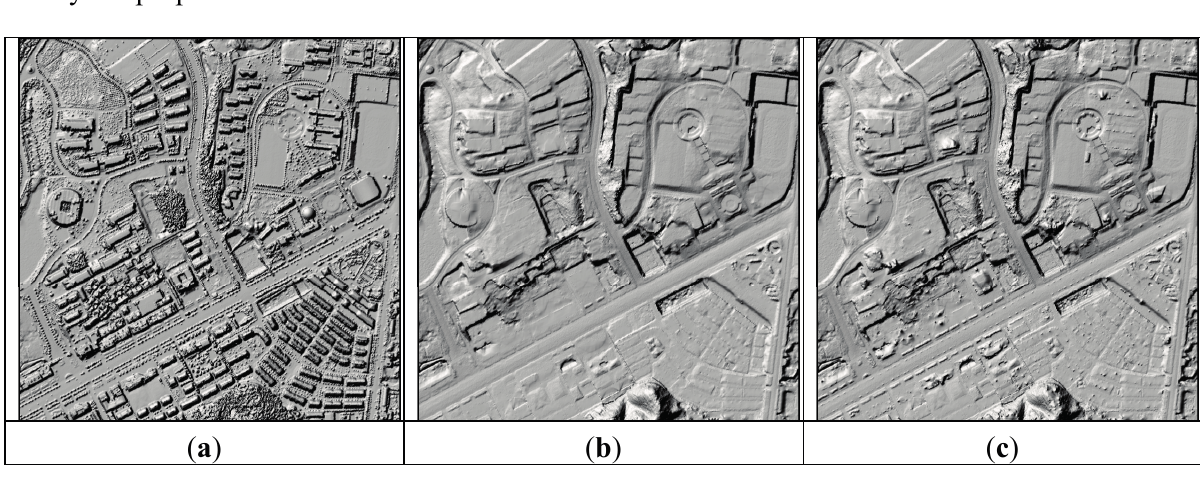
Figure 17. ( a ) DSM generated from the raw point clouds of Xianning City; ( b ) DEM generated from the true ground points; ( c ) DEM generated from the ground points derived by the proposed